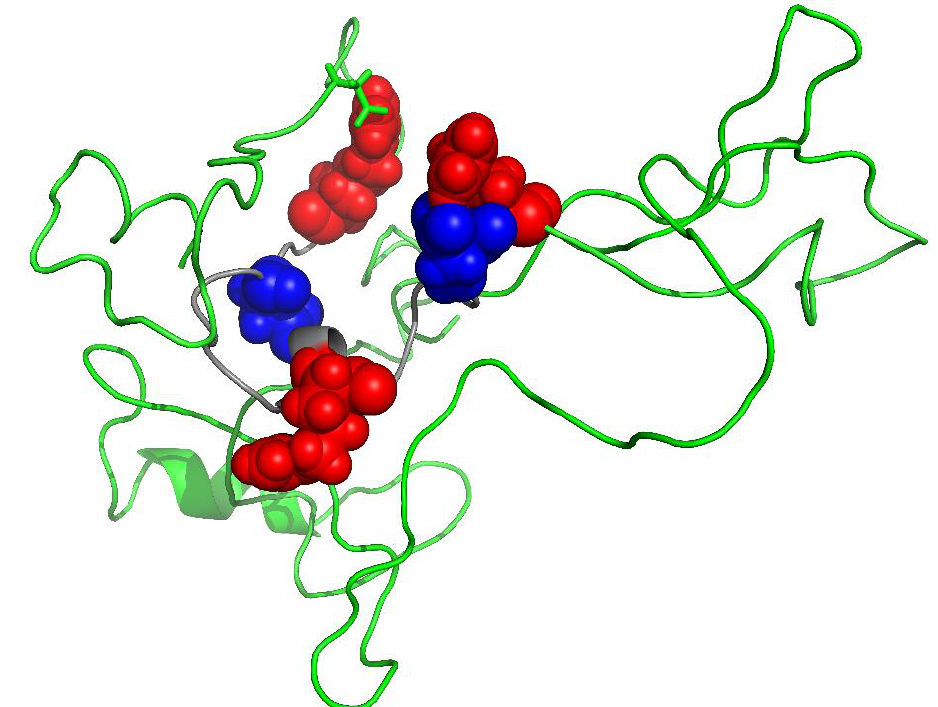
Figure 3. MBP in MS patients is different from MBP in controls. Highlighted in red (Arg) and blue (Asp) are 5 amino acid residues that differ significantly within a 19 amino acid sequence. This cluster includes Arg 31, Asp 34, Arg 43, Asp 48, and Arg 49. For each site, the degree of change is greater in the MS patients; the only exception being Arg 31. Statistical data are shown in Figure 2 and are summarised from Friedrich et al. [9]. The model of MBP was generated using I-Tasser [25] and PyMOL Molecular Graphics System was used to render the 3D structure.